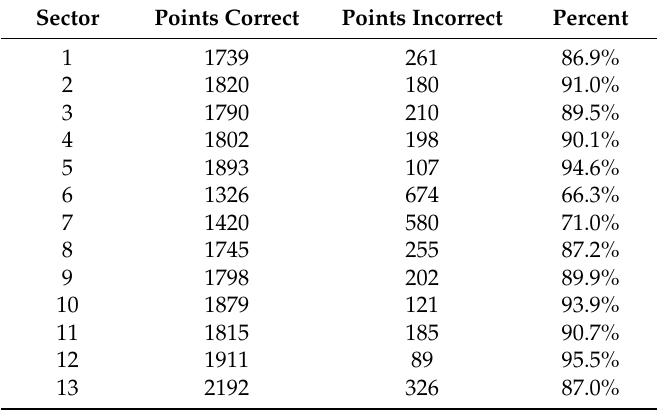
Table 2. Precision test with lane positioning enabled for the mapping system (with computer